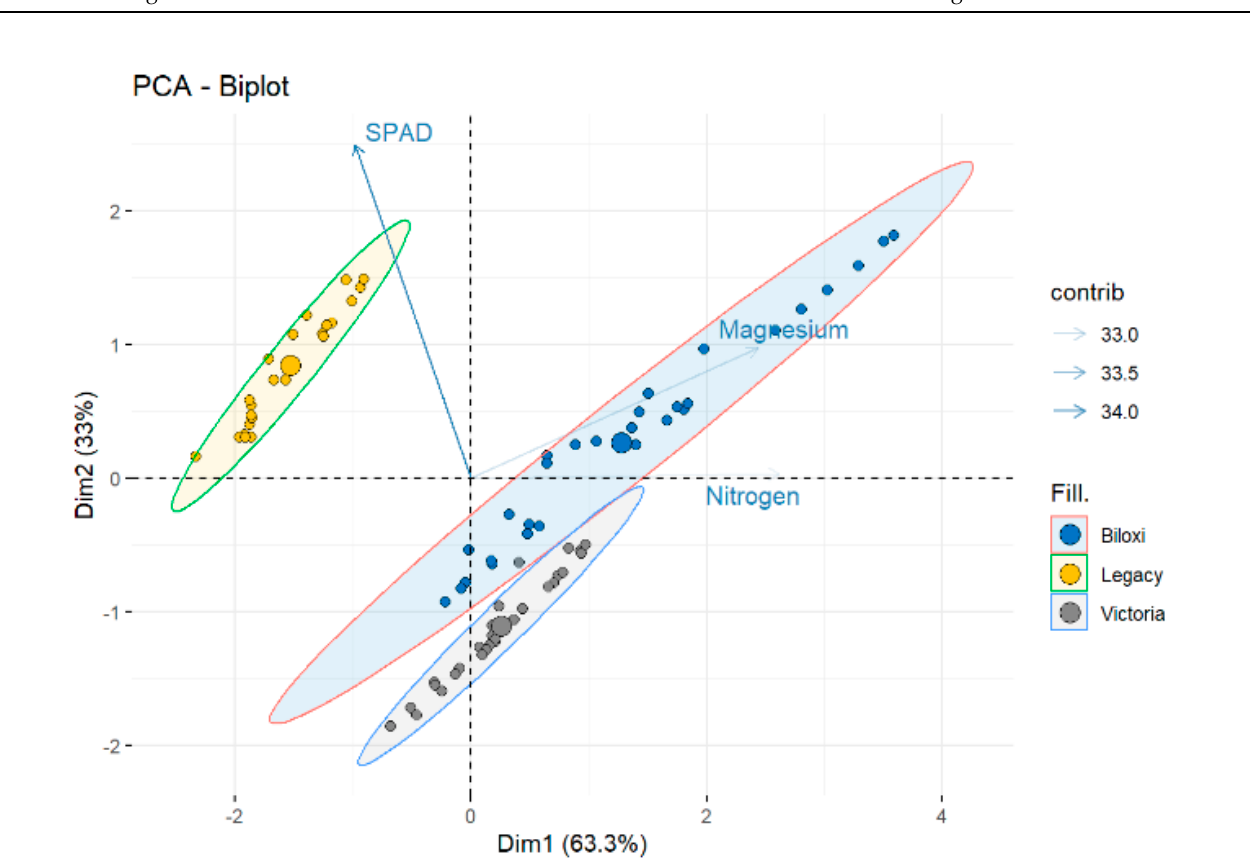
Figure 8. Observational PCA biplot in three blueberry varieties. The PCA biplot shows the scores of the explanatory variables as a vector (arrows in light-blue lines) and individuals of each variety; Biloxi (blue circle), Legacy (yellow circle) and Victoria (grey circle); the colored ellipses (size determined by a probability level of 0.95) emphasize the individuals belonging to each variety.